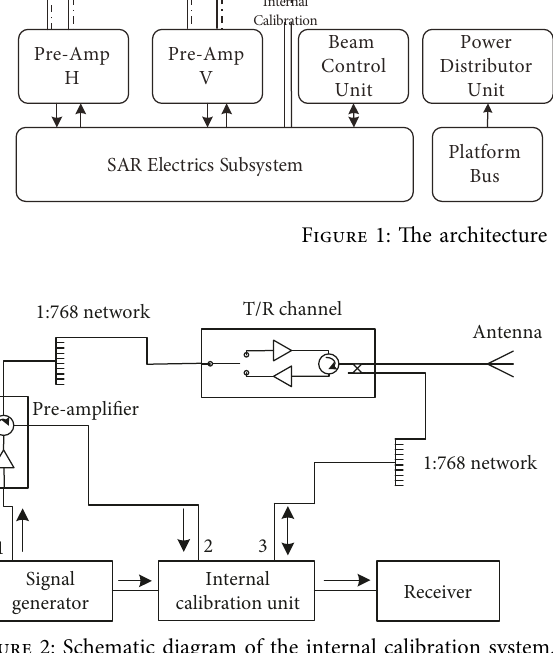
Figure 2: Schematic diagram of the internal calibration system.